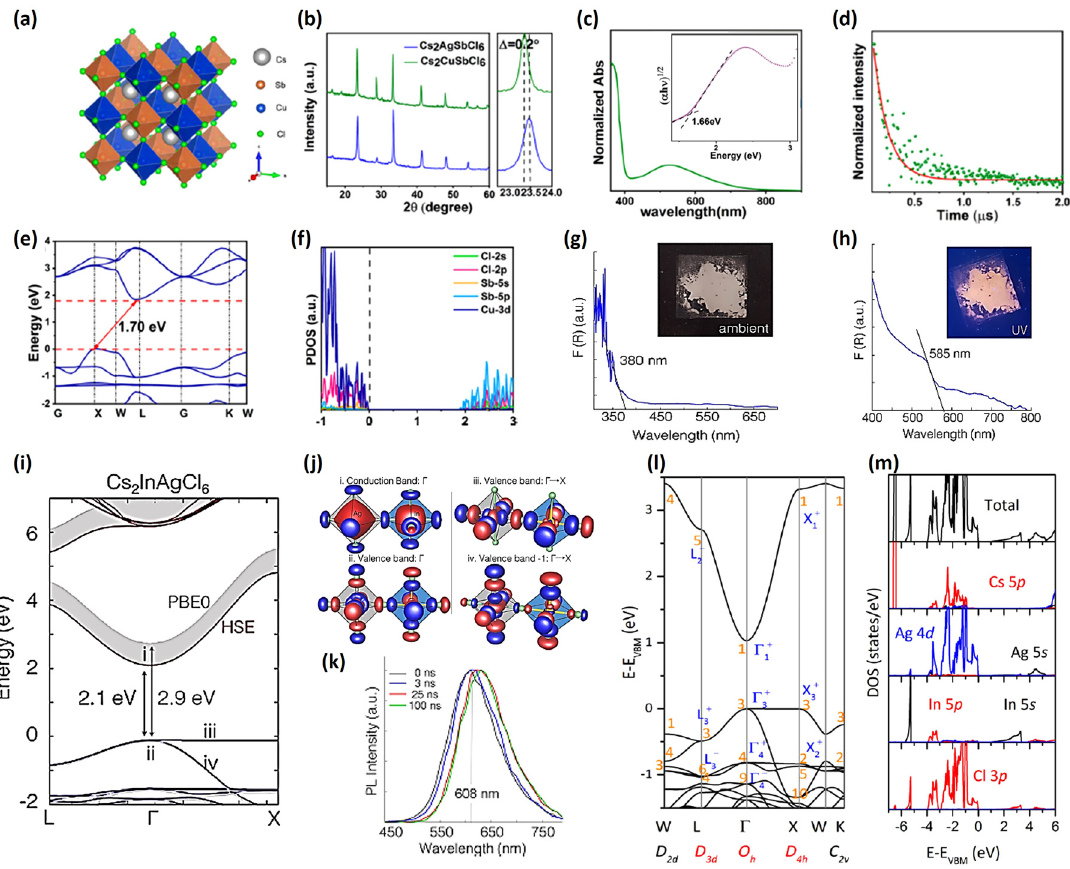
Figure 4: (a) Crystal structure of Cs 2 CuSbCl 6 double perovskite [97]. Copyright 2020, American Chemical Society (b) XRD patterns of Cs 2 CuSbCl 6 nanocrystals [97]. Copyright 2020, American Chemical Society (c) Absorption spectrum of Cs 2 CuSbCl 6 nanocrystals [97]. Copyright2020,AmericanChemicalSocietyInset: CorrespondingTauc plotof Cs 2 CuSbCl 6 nanocrystals.(d)Nanosecondtransientabsorption (TA) signal of Cs 2 CuSbCl 6 nanocrystals [97]. Copyright 2020, American Chemical Society (e) Electronic band structure of Cs 2 CuSbCl 6 . (f) PDOS of Cs 2 CuSbCl 6 double perovskite [97]. Copyright 2020, American Chemical Society (g) UV – Vis absorbance of Cs 2 AgInCl 6 in ambient and (h) under UV illumination (right) [100]. Copyright 2017, American Chemical Society. (i) Band structure of Cs 2 AgInCl 6 double perovskite [100]. Copyright 2017, American Chemical Society. (j) Isosurface plots of Cs 2 AgInCl 6 double perovskite [100]. Copyright 2017, American Chemical Society. (k) Normalized Cs 2 AgInCl 6 PL spectrum of Cs 2 AgInCl 6 double perovskite as a function of time [100]. Copyright 2017, American Chemical Society. (l) Calculated band structure and (m) PDOS of Cs 2 AgInCl 6 double perovskite [103]. Copyright 2017 American Chemical